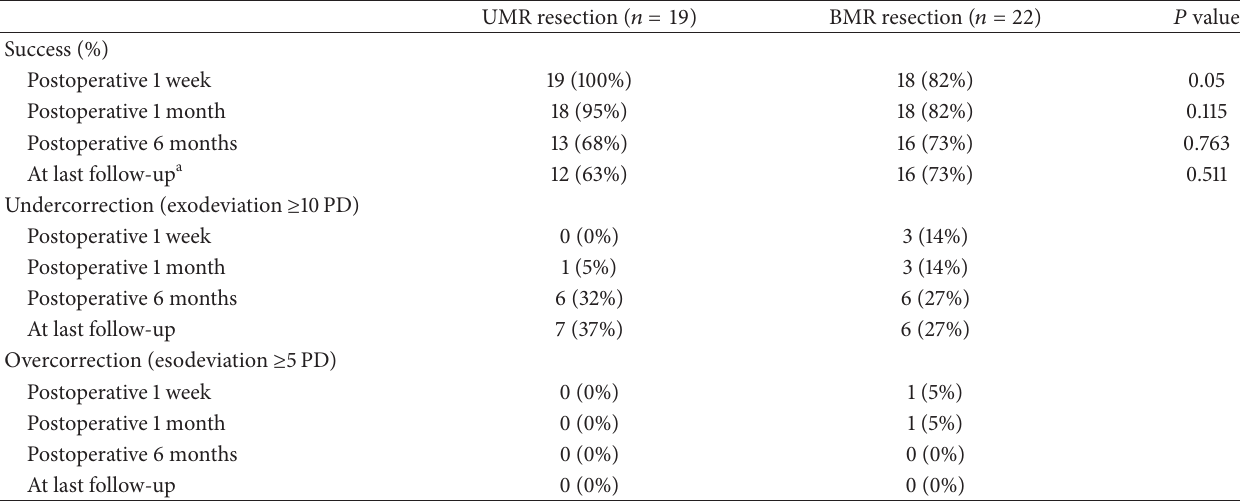
Table 2: Success rates between unilateral and bilateral medial rectus muscle resection groups at postoperative 1 month and 6 months and at last